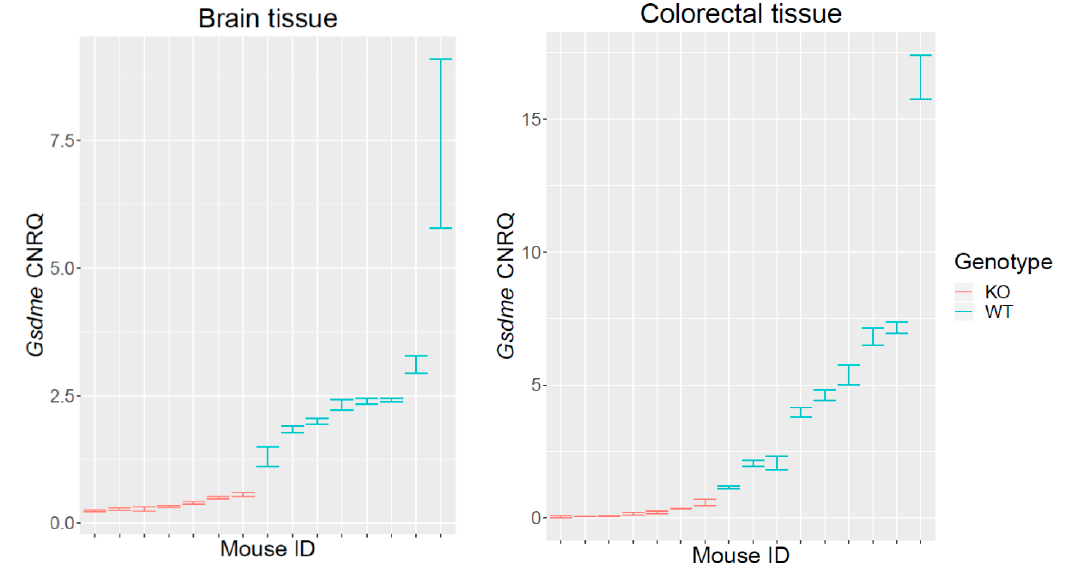
Figure 1. qRT-PCR analyses on Gsdme KO and WT mice. qRT-PCR analyses for Gsdme mRNA expression on Gsdme KO ( n = 7) and WT ( n = 9) mice, both on brain ( n = 15) and colorectal ( n = 16) tissues were performed. The Calibrated Normalized Relative Quantity (CNRQ) ± standard error (se) is represented for every sample. The expression patterns in colon and in brain tissues were similar. There was only very low to no measurable Gsdme expression in Gsdme KO mice, in contrast to WT mice where Gsdme expression was higher and more variable.